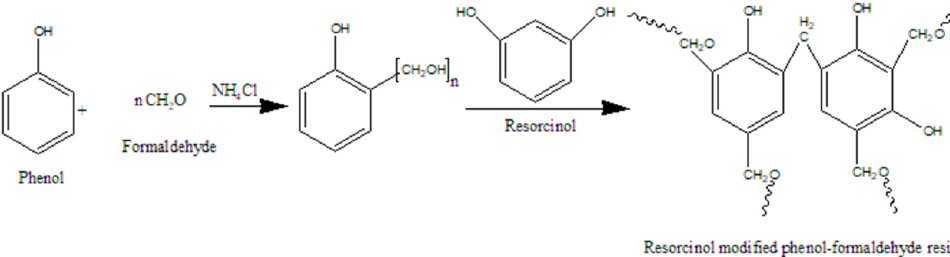
Figure 1. Polymerization reaction .